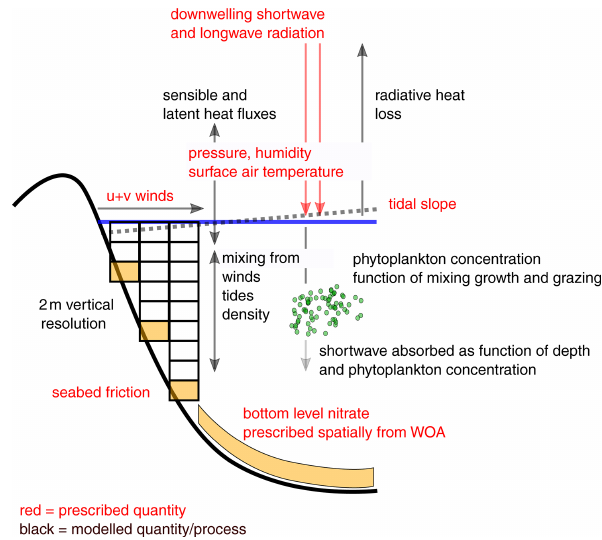
Figure 1. Schematic description of the processes accounted for in S2P3-R v2.0 and prescribed quantities, both forcings and constants. WOA stands for World Ocean